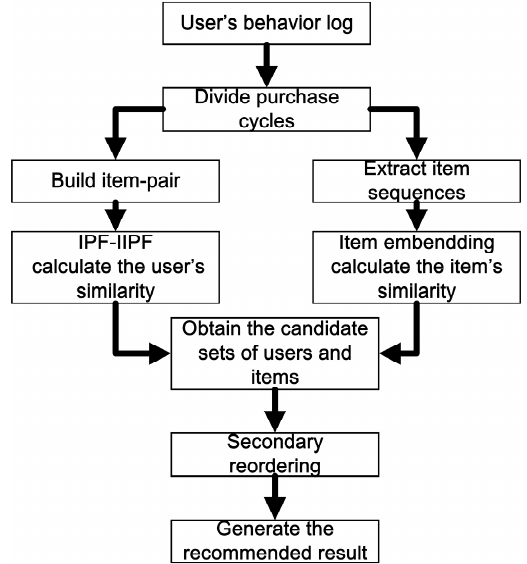
Figure 3. Overview of the recommendation algorithm based on the user’s implicit feedback.